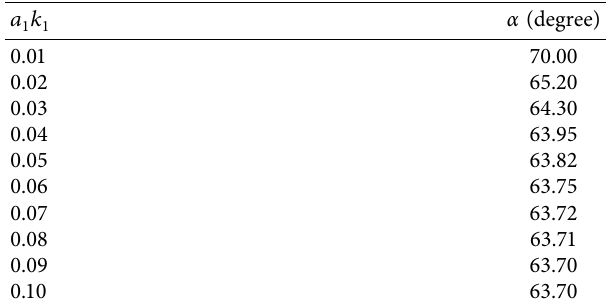
/ Π and a 2 / Π ) versus α of the 1 2 d � 2.5, 1 k � 0.01; dashed line: 1 1 k � 0.03; dash-dotted line: a k � 0.04; 1 1 1 1 k � 0.05; square: a k � 0.06; circle: 1 1 1 1 k � 0.08; cross: a k � 0.09; diamond: 1 1 1 1 � 0.05, and δω � 0. 1